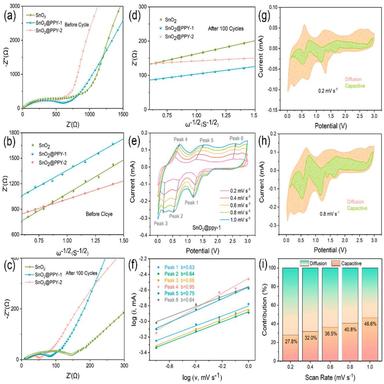
Electrochemical impedance spectra and linear fits between Z′, ω−1/2 of the all electrodes before cycling (a, b) and after cycles (c, d); CV curves of SnO2 @PPy-2 at various sweep rates (e) and log (current, mA) /log (scan rate) plots (f); Capacitive-controlling contribution (green region) at 0.2 mV s −1 (g) and 0.8 mV s −1 (h); Histogram of the pseudocapacitive contribution rate (i).